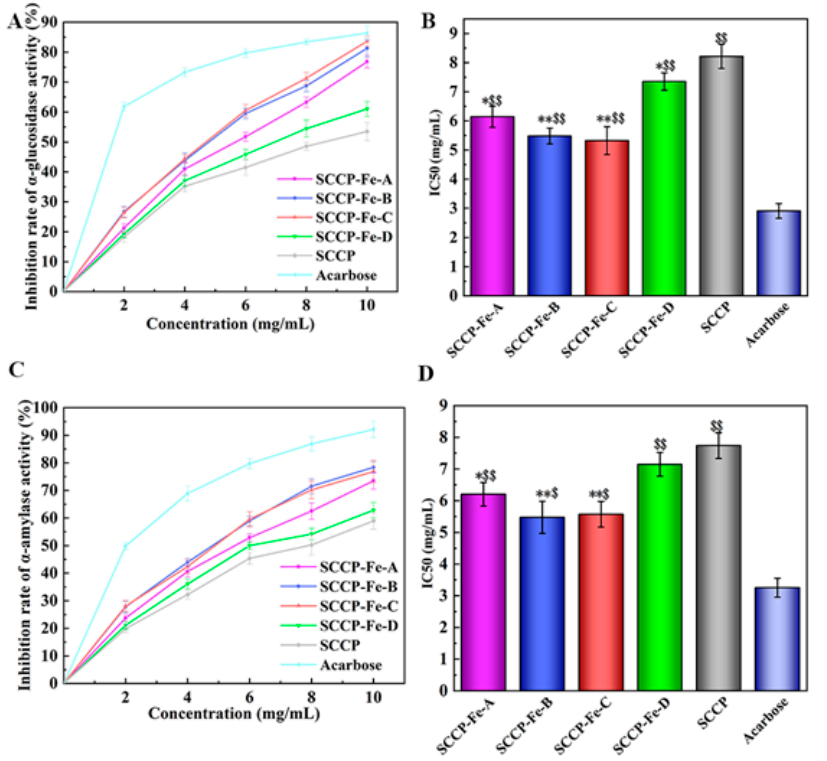
Figure 8. Hypoglycemic activity of four sweet corn cob polysaccharide-iron (III) complexes. (( A , B ): The inhibition rate of α -glucosidase activity and its IC50. ( C , D ): The inhibition rate of α -amylase activity and its IC50. *: p < 0.05 compared to SCCP; **: p < 0.01 compared to SCCP; $: p < 0.05 compared to Acarbose; $$: p < 0.01 compared to Acarbose.).